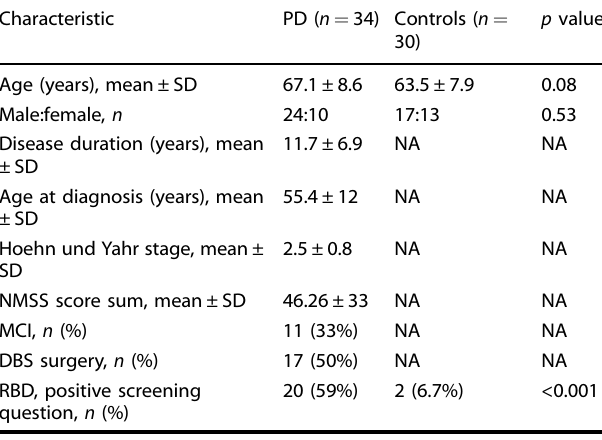
Table 1. Demographic and clinical data of patients and controls.